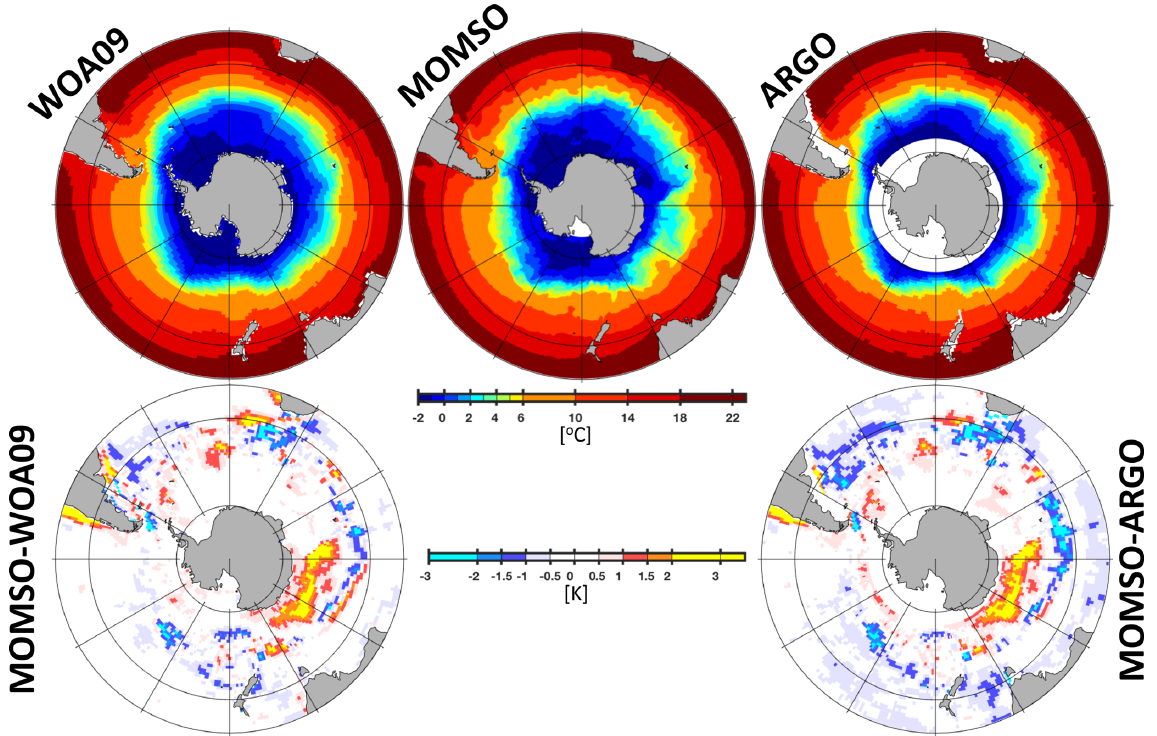
Figure 12. Climatological mean sea surface temperature. WOA09 and Argo (2004–2017 period) refer to observations compiled by Locarnini et al. (2010) and Roemmich and Gilson (2009), respectively. MOMSO refers to an average over the nominal 1993–1998 period of the reference simulation. The upper (lower) panels show sea surface temperature (differences).